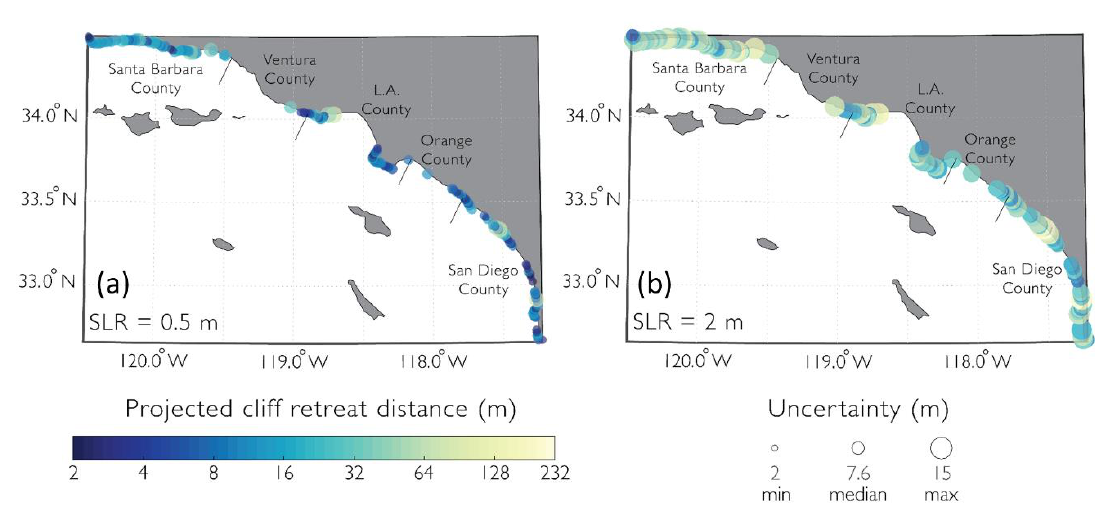
Figure 2. Map of cliff recession model results for two sea-level rise (SLR) scenarios: ( a ) 50 cm SLR and ( b ) 200 cm SLR. The colors represent cliff retreat distance, while the size of the marker represents the amount of uncertainty.